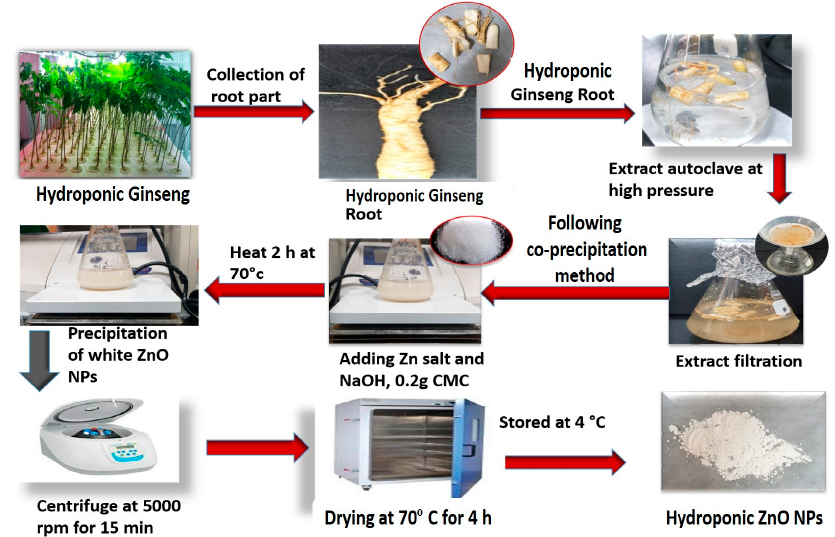
Figure 10. Synthesis of HGRCm-ZnO NPs from hydroponic ginseng root and CMC polymer.